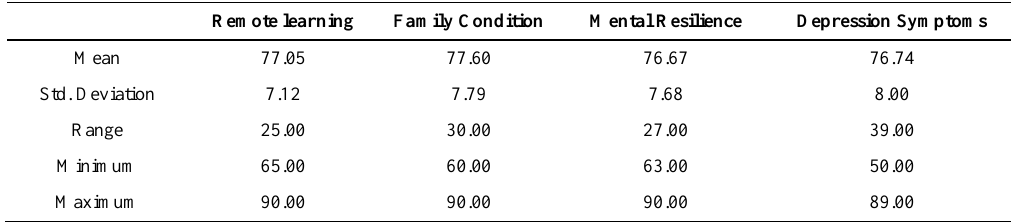
Table 5. The Descriptive Analysis of Remote Learning Variables, Family Condition, Mental Resilience, and